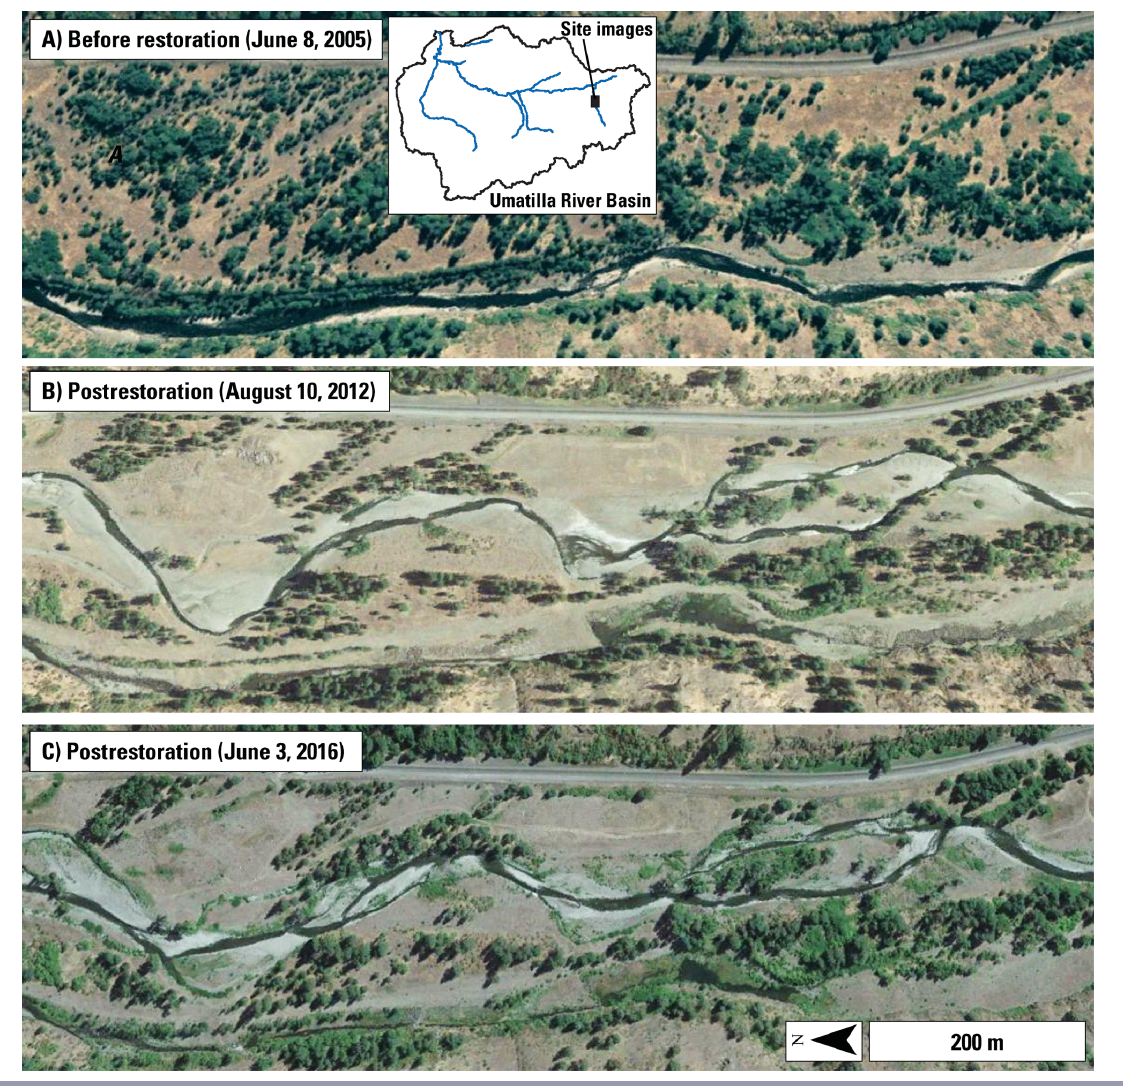
Fig. 10 . Images of a portion of the Meacham Creek habitat restoration site: (A) Before restoration (8 June 2005), (B) Immediately after restoration (10 August 2012), and (C) Four years post restoration (3 June 2016). Images are from Google